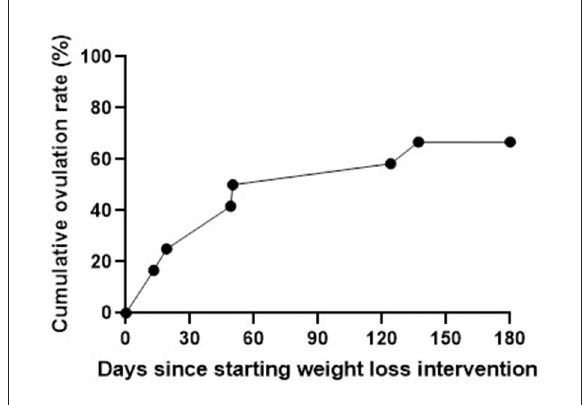
FIGURE1 Ovulation rates via OPK across weight loss intervention.